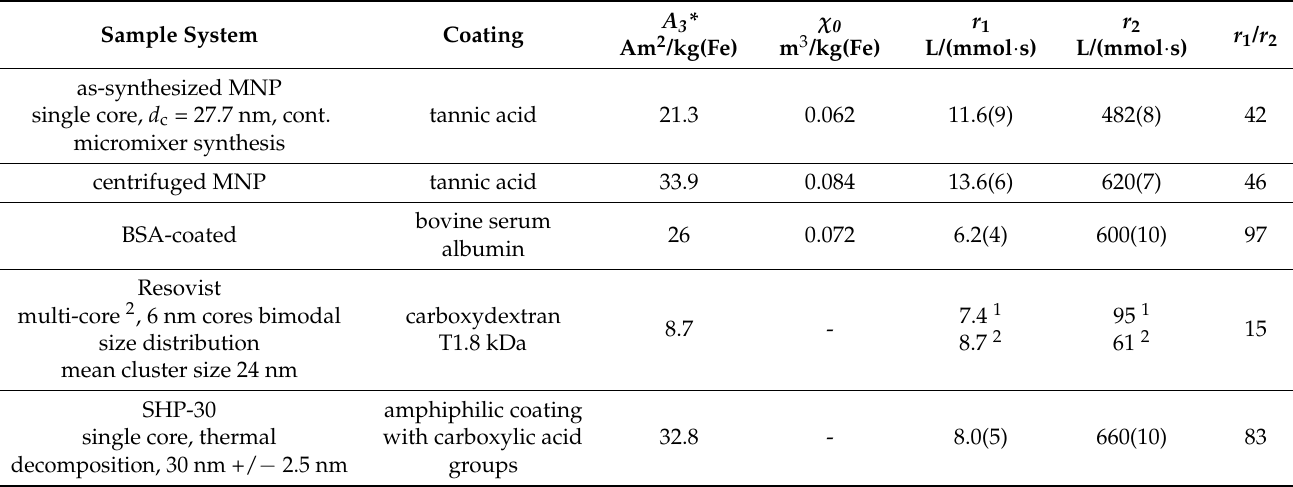
Figure 5. Room temperature NMR relaxation rates R 1 ( a ) and R 2 ( b ) measurements as a function of iron concentration c (Fe) of as-synthesized, centrifuged, and BSA-coated MNP measured at 1.5 T. The relaxation rates are obtained by linear regression and drawn as straight lines; the corresponding for the r 1 and r 2 values are listed in Table 1. Table 1. Properties of the investigated MNP systems together with the two commercial MNP systems, Resovist and SHP-30 MNP. System information and coating are provided in the first two columns, followed by magnetic parameters obtained by MPS (amplitude of the 3 rd harmonic normalized to iron amount, A3*), ACS (initial susceptibility χ 0 ), and NMR (relaxivities r 1 and r 2 and the ratio r 2 / r 1 measured at 1.5 T).